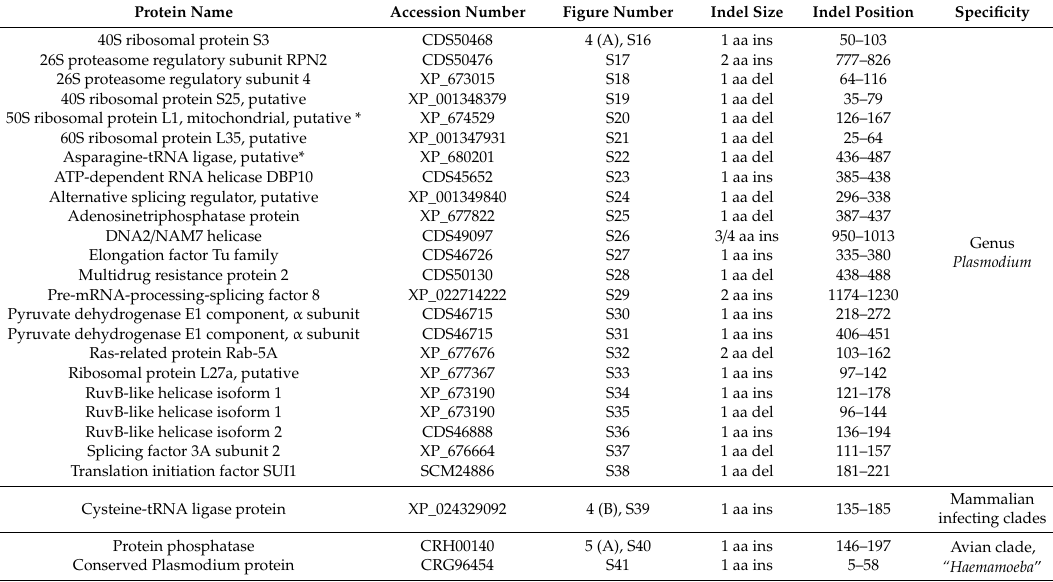
Table 2. Summary of CSIs specific for the Genus Plasmodium and some of its clades /